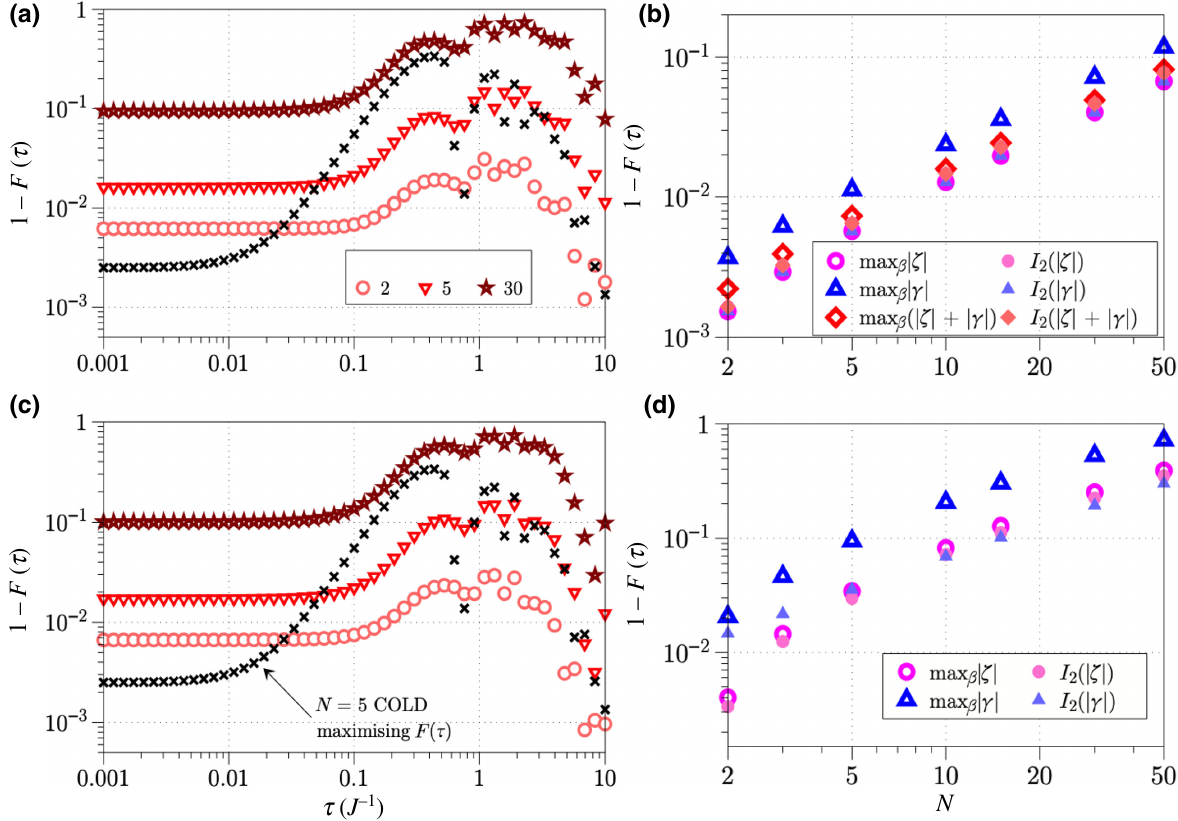
FIG. 8. Optimization of β via minimizing second-order LCD terms for the Ising model (all plots show 1 − F ). In (a) we plot the final state fidelities after minimizing the integral from Eq. (22) of the | ζ( t ) | drive [ I 2 ( | ζ( t ) | ) ] and then apply the result at each driving time to different system sizes N . The results of minimizing the maximum amplitude max β | ζ( t ) | instead are plotted in (c). The black crosses in both (a) and (c) are the results of optimizing β by maximizing the final state fidelity F (τ) and are the same as the red circle plot in Fig. 2(a). Plotted in (b) and (d) are final state fidelities for τ = 0.1 J − 1 for different system sizes N when optimizing β either by minimizing the maximum amplitude of a drive max β ( · ) or its integral I 2 ( · ) . In (b) only first-order COLD is applied postoptimization, while in (d) one of the second-order drives is also applied after minimizing the other, e.g., if max β | ζ | is minimized to determine the optimal β then both the first-order drive α and the other second-order drive γ are applied. For system sizes above N = 10, we use ITensor [60] matrix product state calculations that are converged with a truncation level of 10 − 14 per time step and at each site reaching a maximum bond dimension of 4. In all cases, a single optimizable parameter is used ( N k =